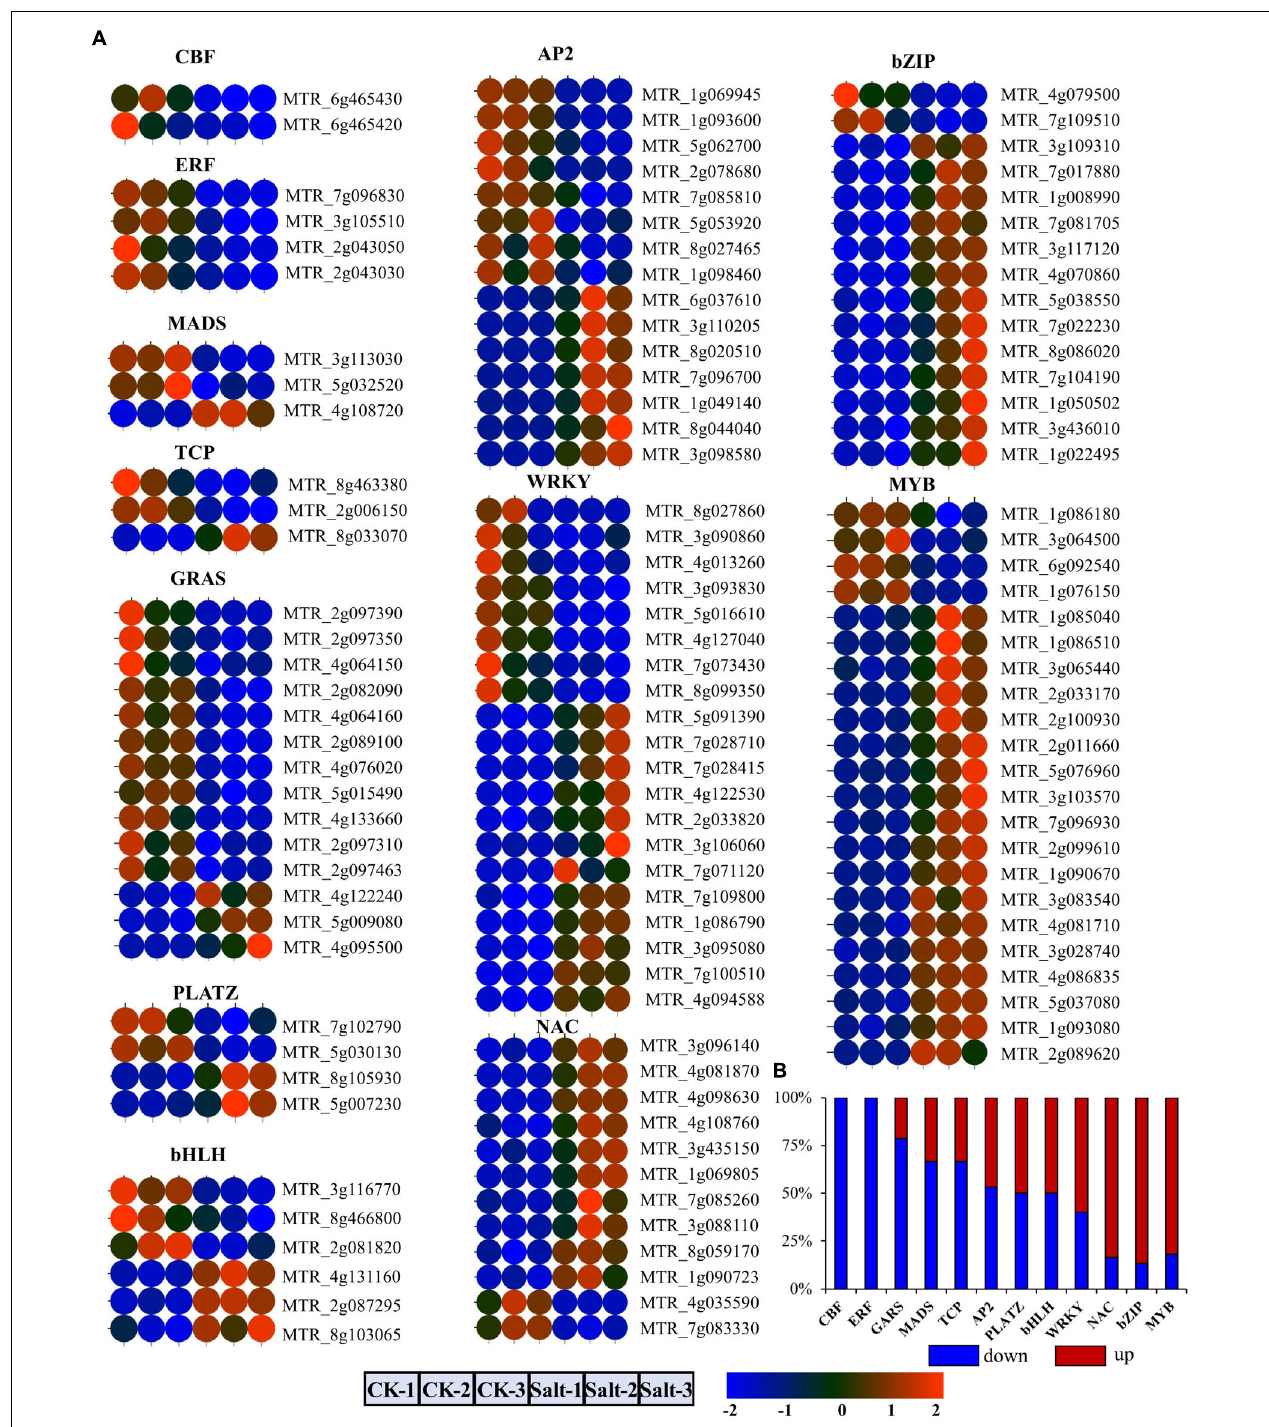
FIGURE 2 | Identification and analysis of differentially expressed TFs under salt stress. (A) The expression level of 12 TFs in six samples. (B) Histogram of up-regulated and down-regulated genes in 12 TF families.